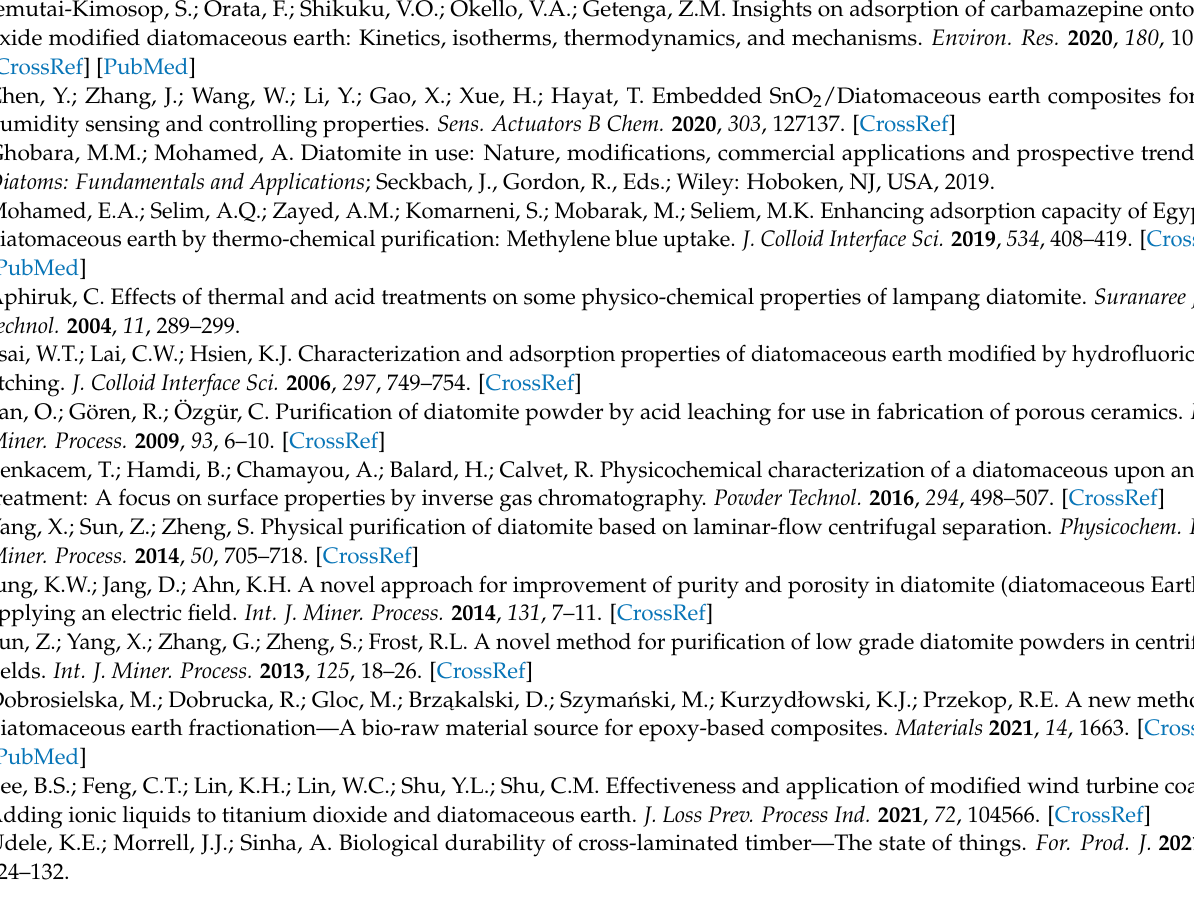
Figure S3: Standard deviation at the maximum elongation for degassed and non-degassed composites containing base diatoms and rinsed diatoms; Figure S4: Standard deviation at the flexural stress for degassed and non-degassed composites containing base diatoms and rinsed diatoms; Figure S5: Standard deviation at the impact strength for degassed and non-degassed composites containing base diatoms and rinsed